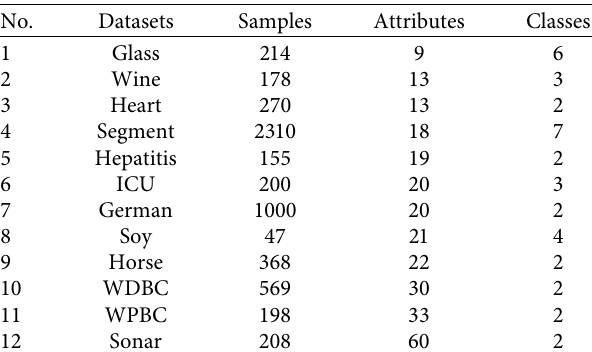
Table 1: Descriptions of 12